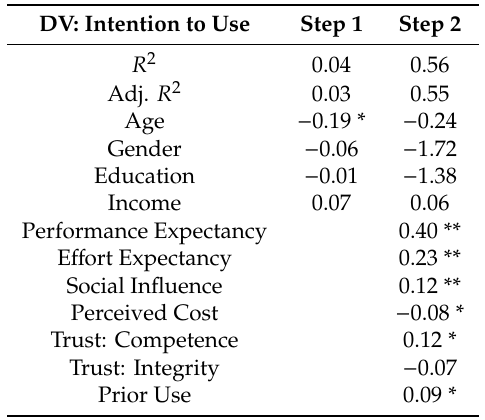
Table 1. Hierarchical multiple regression model